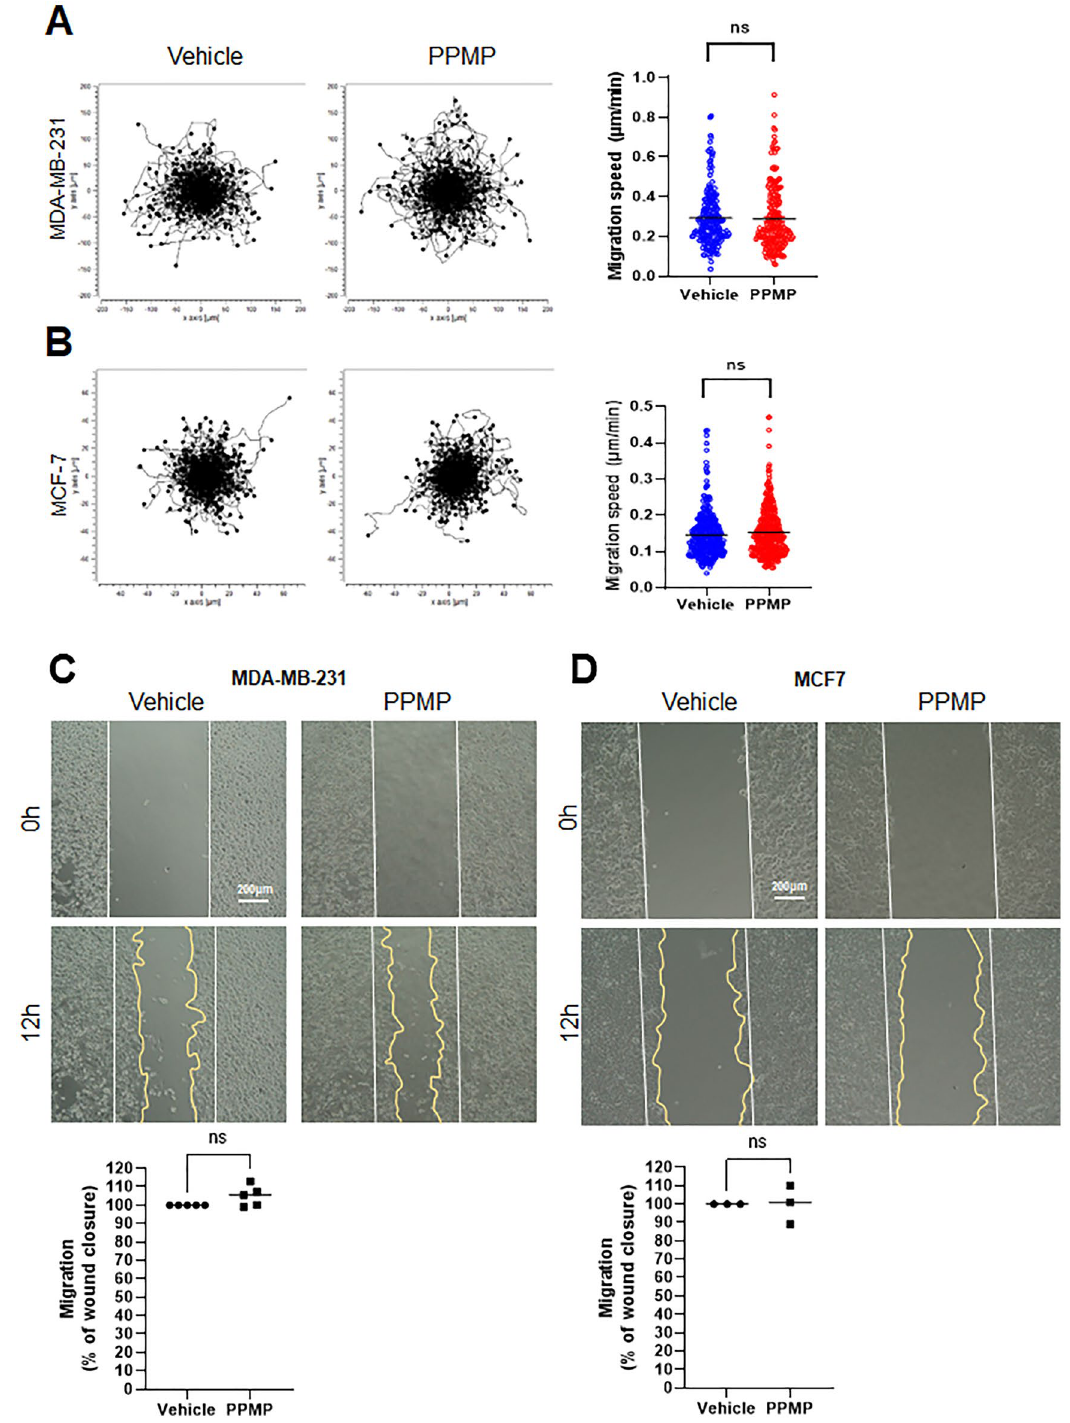
Figure 3. Effect of PPMP on breast cancer cell motility. ( A ) Both breast cancer cell lines were incubated with PPMPs and observed under a time-lapse imaging microscope for six hours. The plots depict the motility of individual cells in the representative experiment. ( B ) Quantification of the migration speed reveals unchanged cellular velocity by the PPMPs treatment in both cell lines. The results are expression as the mean ± SEM ; n = 360 individual cells for both cell lines. (unpaired two-tailed t test, p = 0.7629 for the MDA-MB-231 cells and p = 0.1116 for the MCF-7 cells). ( C ) and ( D ) Effects of the PPMPs on the ability of wound healing in the MDA-MB-231 and MCF-7 cell lines. Photos in each group were taken at 0 hours and 12 hours after the PPMP treatment. The closed area (indicated yellow line) was quantified by Image J software. Experiments were repeated independently three times for the MCF-7 cells and five times for the MDA-MB-231 cells (unpaired two-tailed t test; p = 0.0684 for the MDA-MB-231 cells, p = 0.7760 for the MCF-7